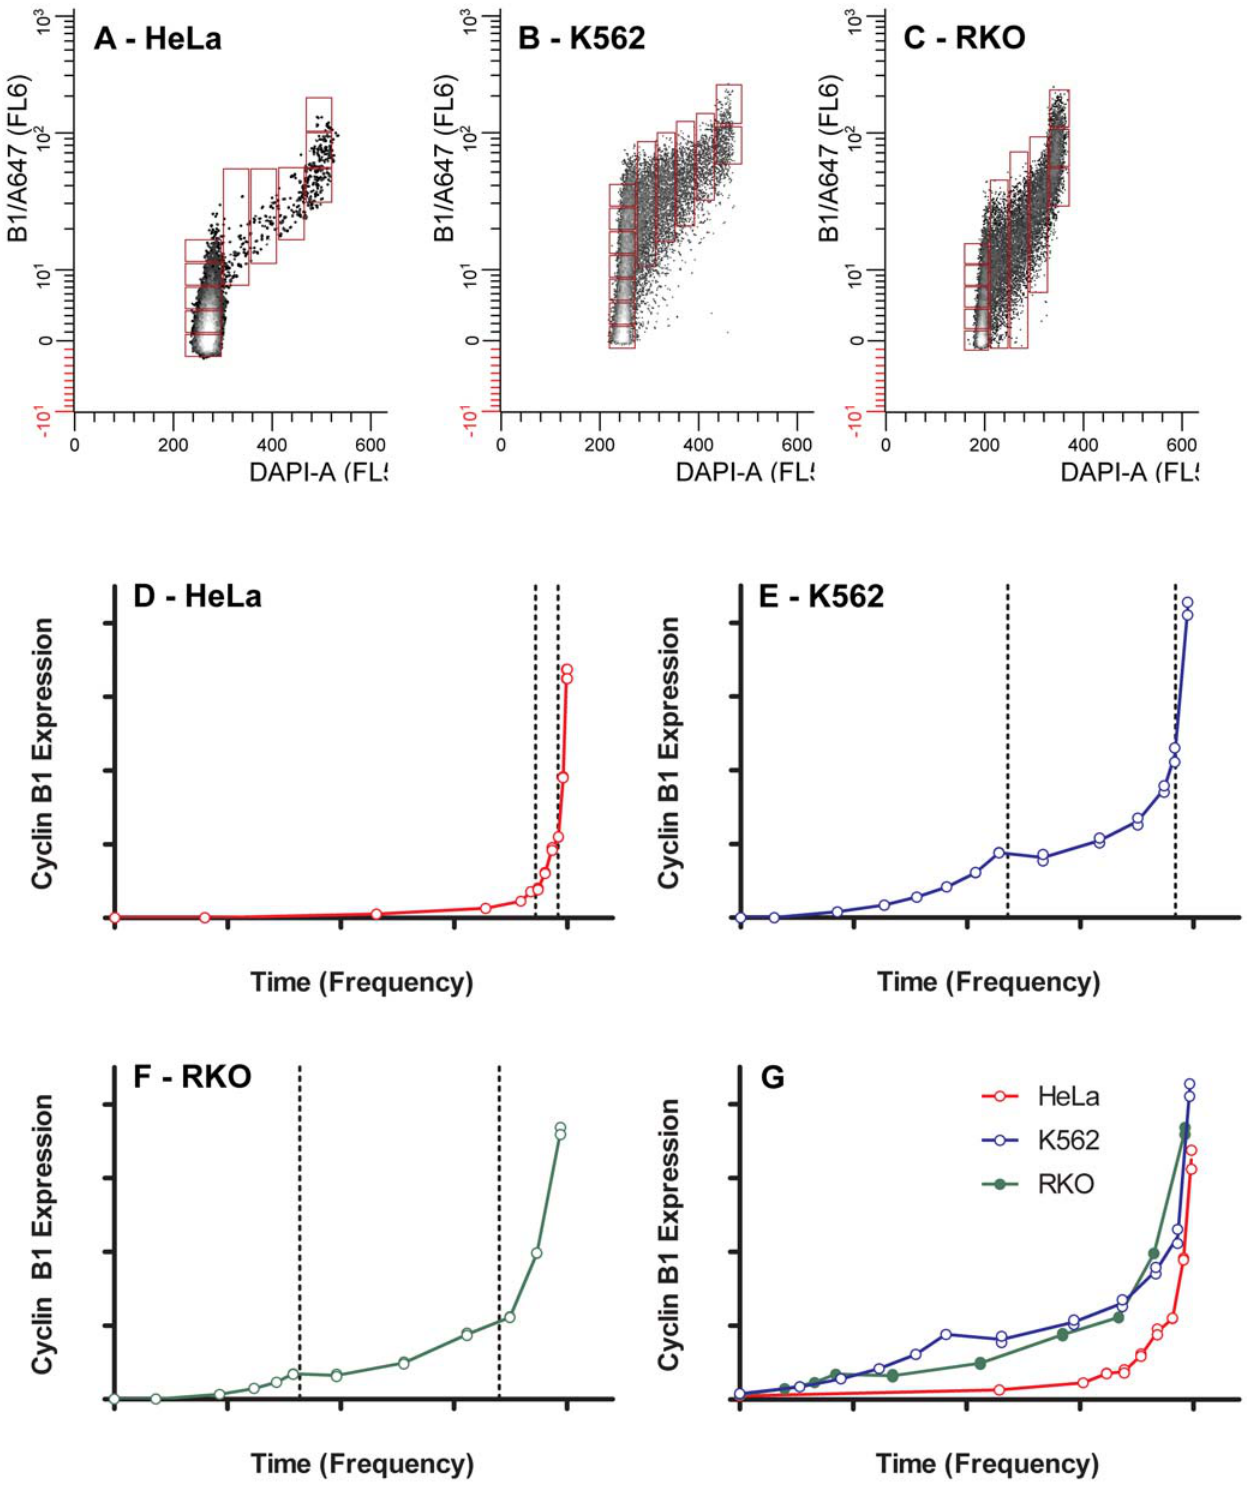
Figure 8. Cell cycle expression of cyclin B1. The cytometric data for HeLa, K562, and RKO cells (Figure 7) were gated to exclude endoreduplicated or binucleate cycling cells (4C 8C); mitotic cells after metaphase, and outliers. The purpose was to expose only the cells distributed about the two dimensional center as a function of DNA content. These data represent the most common cycling cell in the population. Arbitrary regions were set, moving through the data from early G1 through late G2 + M ( A–C ). The mean cyclin B1 levels from each region are plotted as a function of the cell frequency in the region ( D–F ). The frequency data were renormalized from the first non-zero cyclin B1 point and plotted to compare the committed part of the cell cycle (cyclin B1 is detectable) for each cell line ( G ). In A-G, the X axis scale is 0–1, and the Y axis scale is 0– 4 6 10 6 .